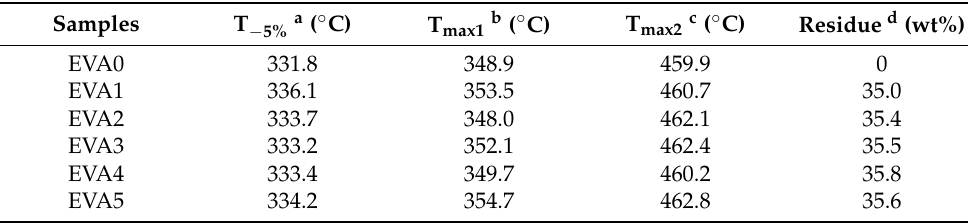
Figure 5. ( a ) TG and ( b ) DTG curves of neat EVA and EVA/MH composites. Table 4. TG data of neat EVA and EVA/MH composites.